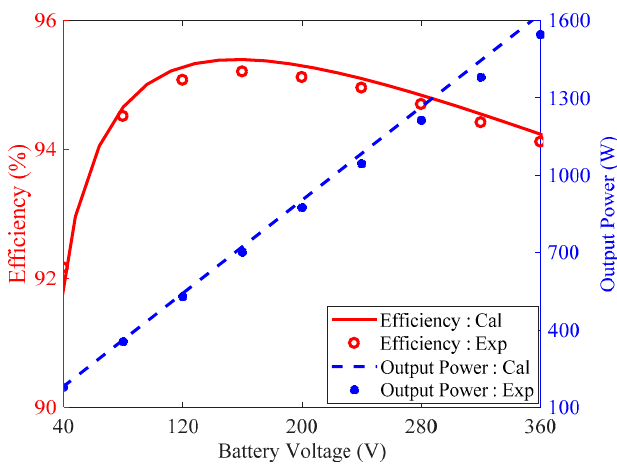
Figure 11. The efficiency and output power varying with the battery voltage.